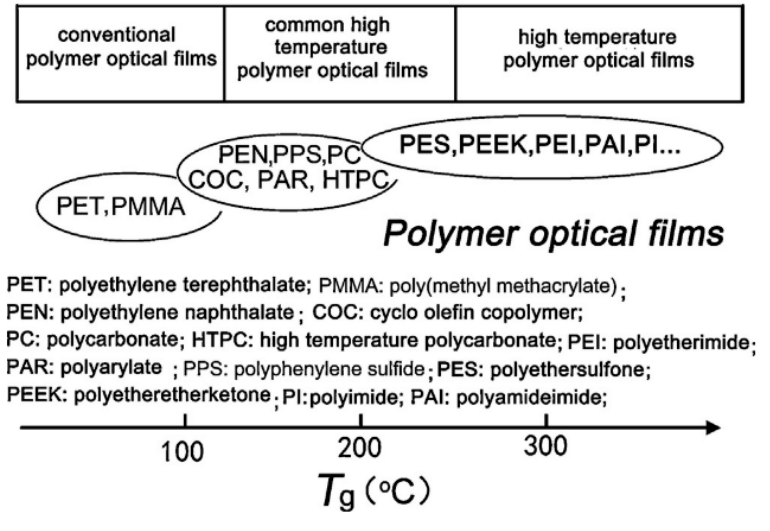
Figure 2. Classification of polymer optical films [149].